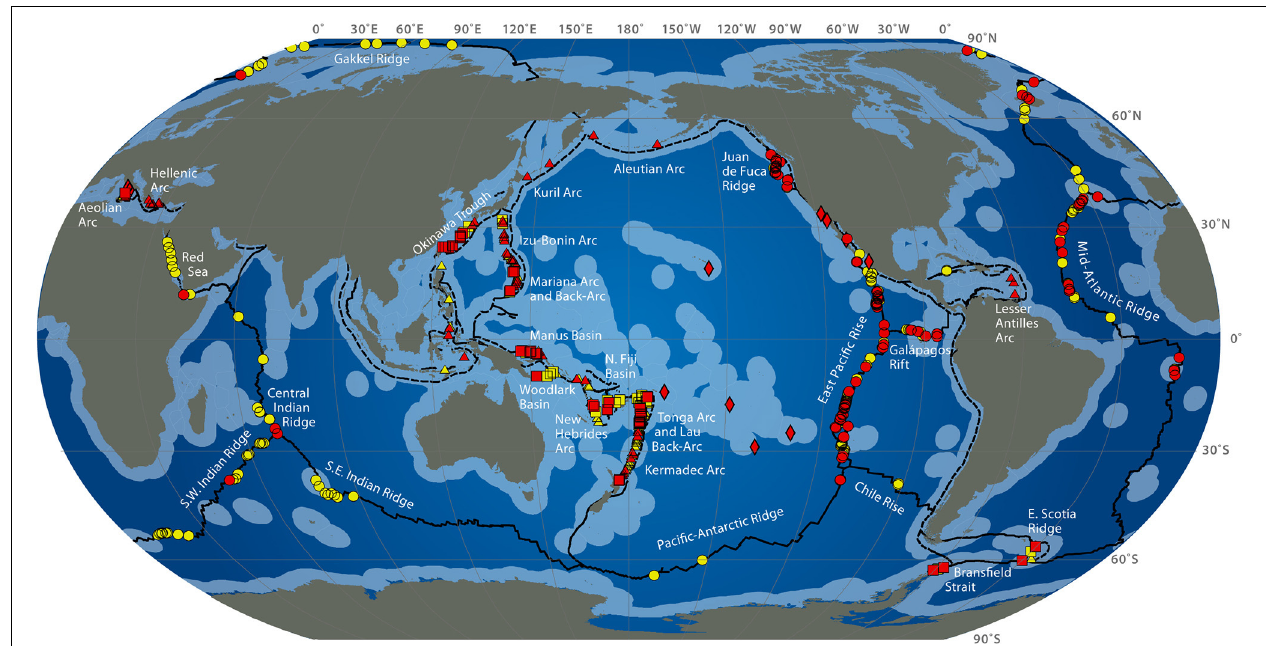
FIGURE 1 | Global distribution of hydrothermal vent fields (2009) from http://www.interridge.org/irvents/files/Ventmap_2009.jpg, accessed 2014, September 9. Hydrothermal vent sites from Mid-Ocean Ridge (circles),